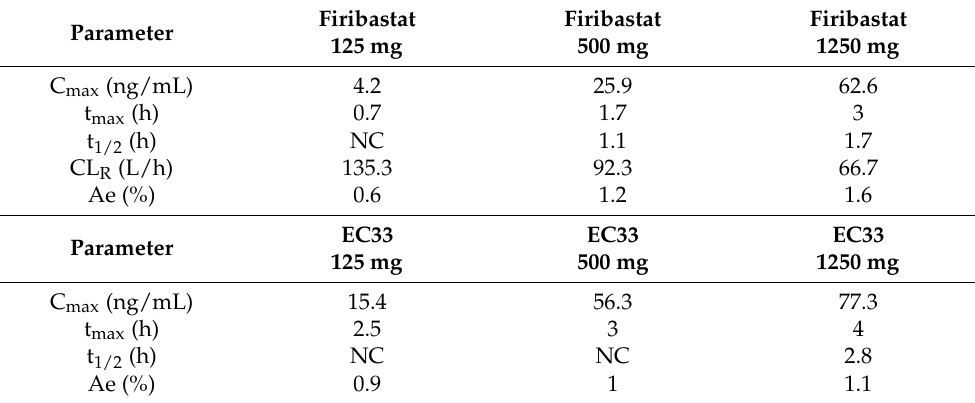
Table 1. Overview of plasma pharmacokinetic parameters for firibastat and